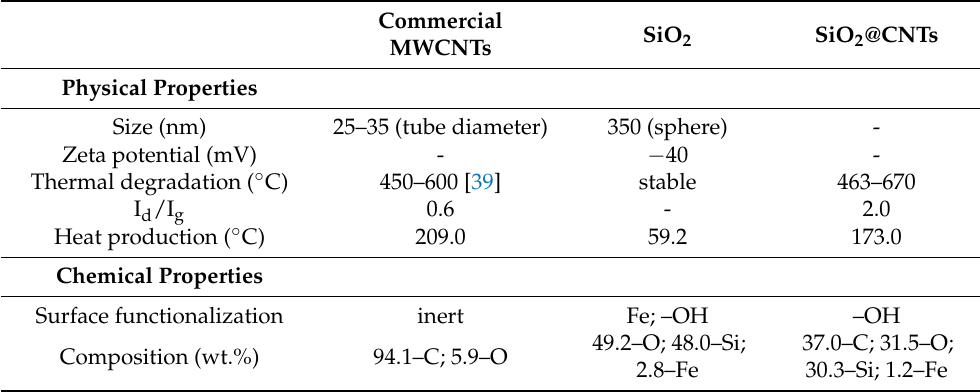
Table 1. Tabulated values of physical and chemical properties of the used